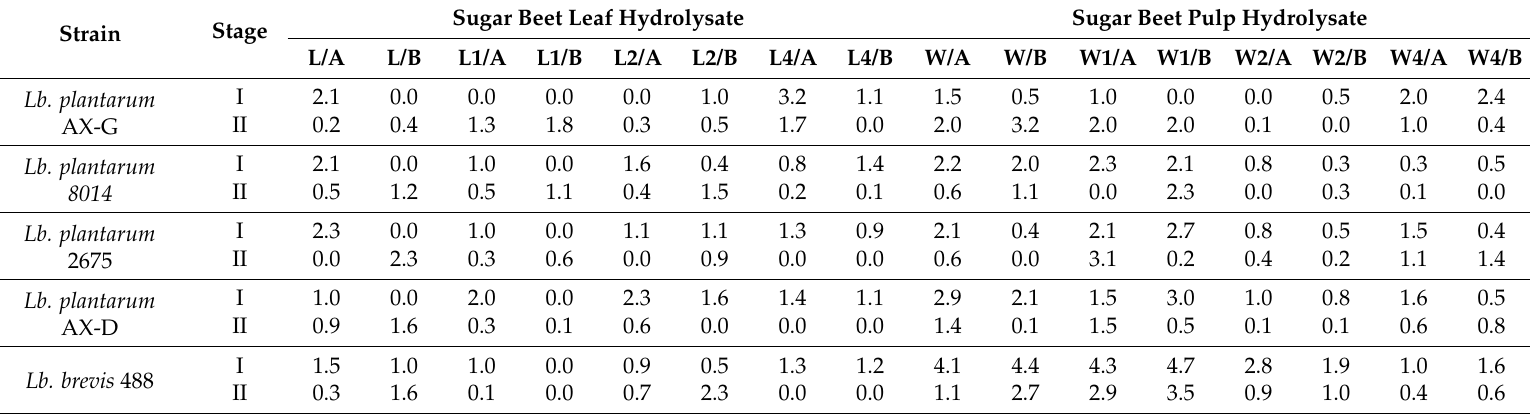
Table 7. Growth of selected lactic acid bacteria strains on biomass hydrolysates (increase in optical density ( ∆ McF)). Strain